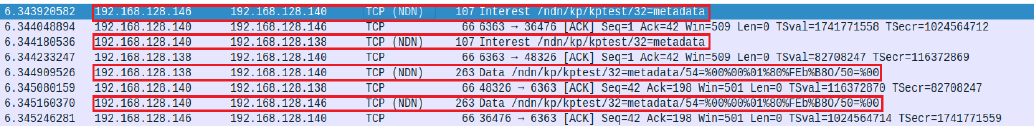
Figure 4. Interplanetary File System local file storage.